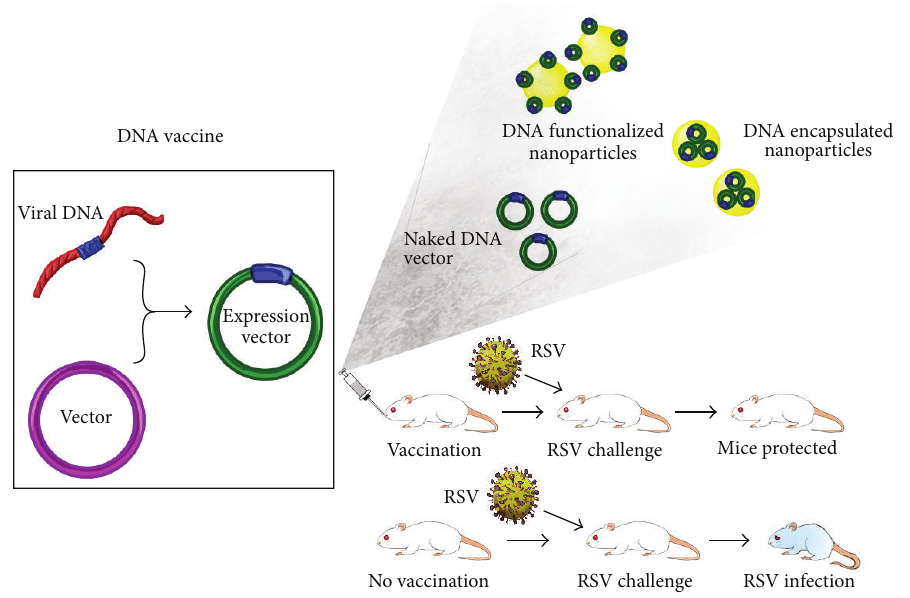
Figure 6: A schematic representation of a simple DNA vaccine administered as a naked DNA vector or functionalized nanoparticle or as an encapsulation for controlled